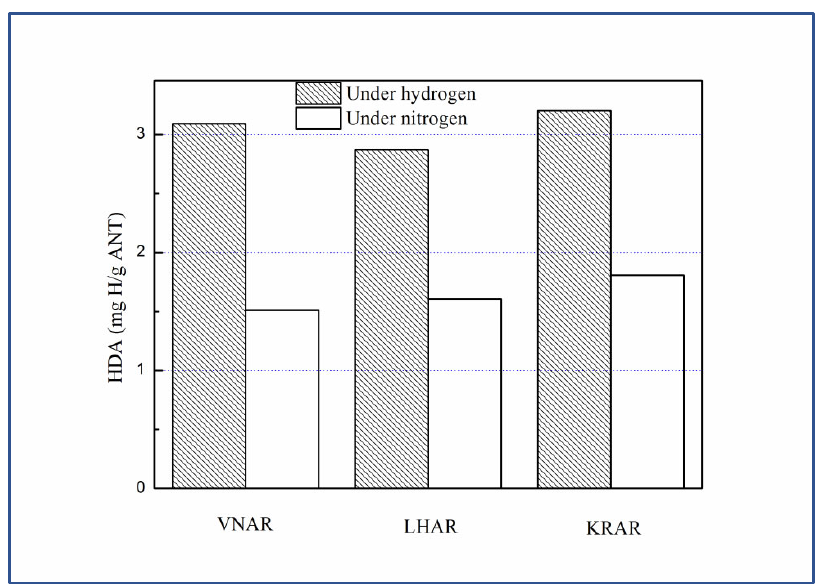
Figure 2. HAA of the three residues.